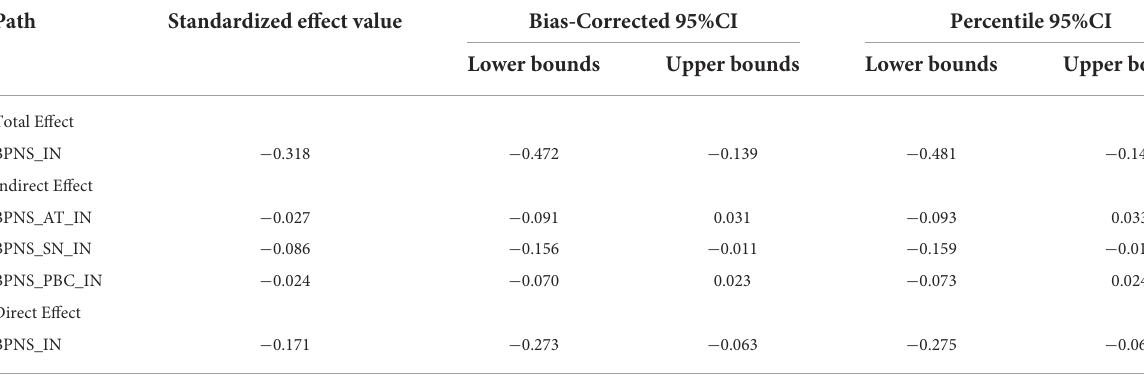
TABLE 7 Bootstrap results of mediating